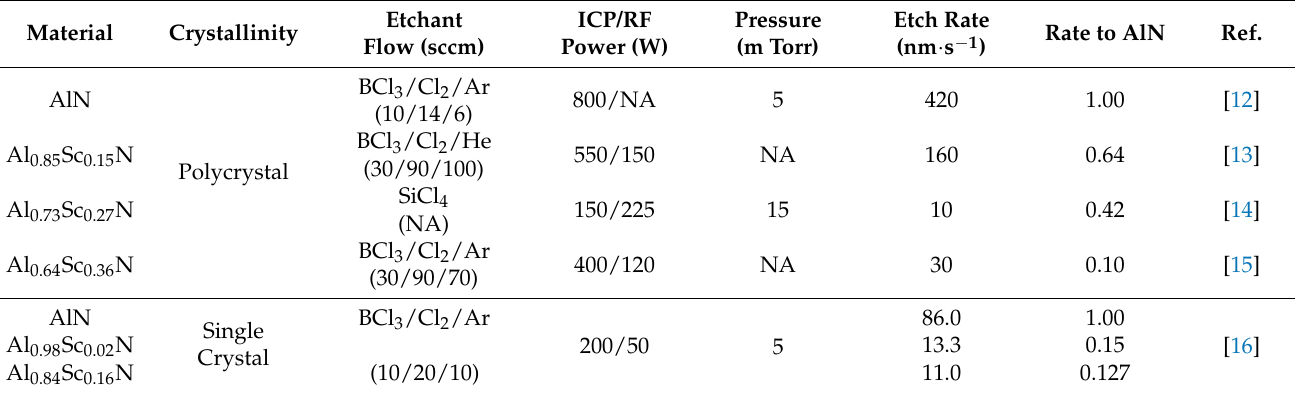
Table 1 summarizes selected studies on the dry etch rates of AlN/Al 1 − x Sc x N: Table 1. Published dry etch rates of AlN/Al 1 − x Sc x N in